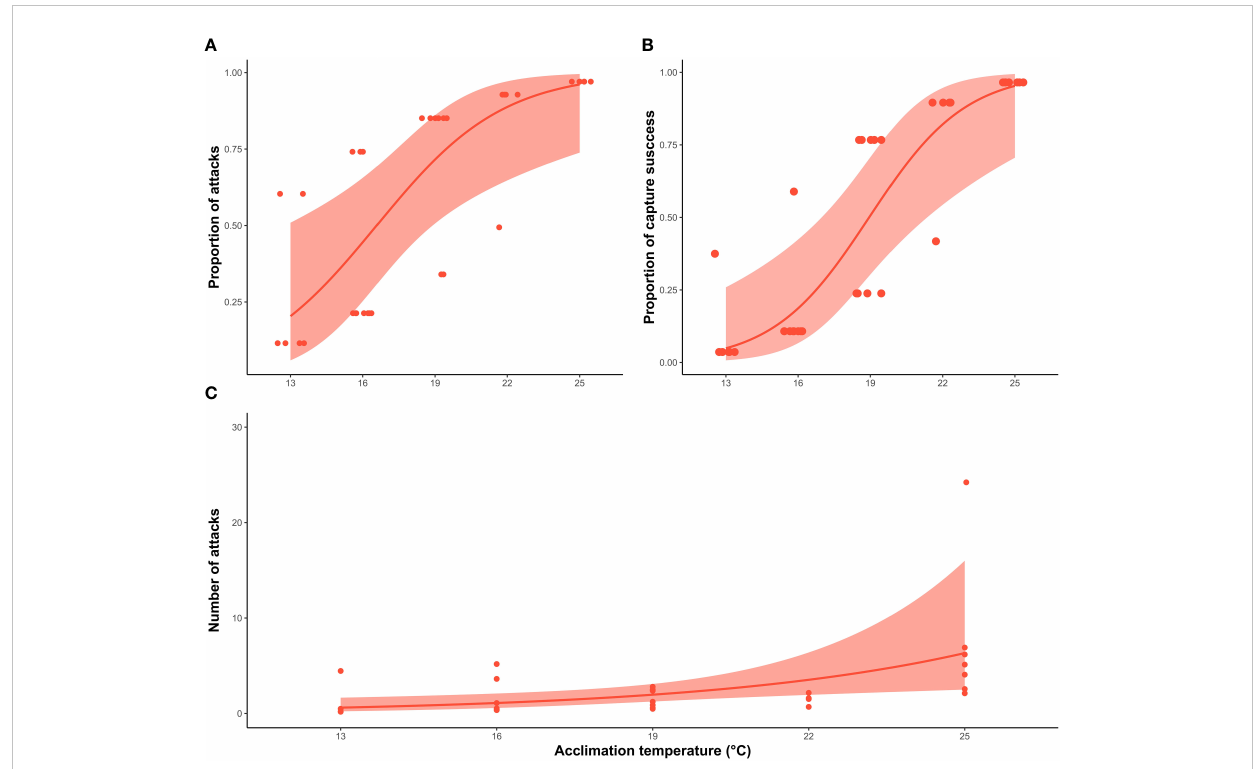
FIGURE 3 Relationship between behavioural responses of southern calamari ( Sepioteuthis australis ) and the fi ve different acclimation temperatures (13, 16, 19, 22 and 25°C). (A) GLM with binomial distribution of the probability that individual squid will make an attack. (B) GLM with binomial distribution, of capture success of squid per treatment (C) GLM with a negative binomial distribution modelling the total number of strike attempts, including when squid were not successful. The thick line represents the expected value of the model for the variable measured. The shadow band corresponds to the 95% con fi dence interval, and the individual squid values are represented by the red